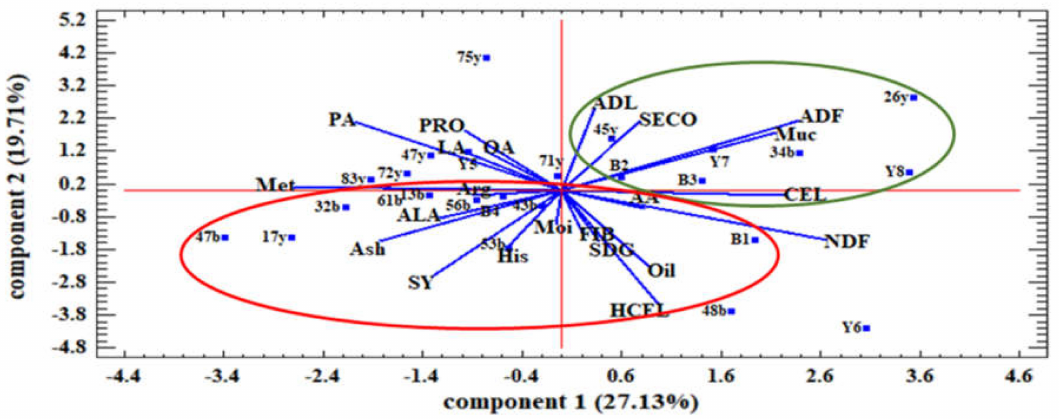
Figure 5. Principal component analysis of the relationship among the studied traits and the distri- bution of flax families relative to these traits under water stress conditions. SY: seed yield. Oil: oil content. NDF: neutral detergent fibers. ADF: acid detergent fibers. ADL: lignin. CEL: cellulose. HCEL: hemicellulose. Muc: mucilage. PRO: protein content. FIB: fiber content. OA: oleic acid. LA: linoleic acid. PA: palmitic acid. ALA: α - Linolenic acid. Met: methionine. His: histidine. Arg: arginine. AA: aspartic acid. Moi: moisture. SDG: secoisolariciresinol diglucoside. SECO: